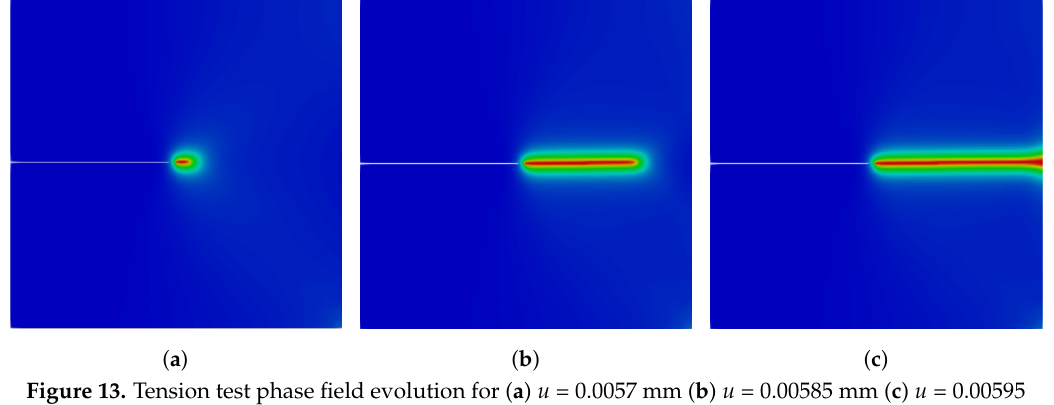
Figure 12. Tension test load-deflection curves.